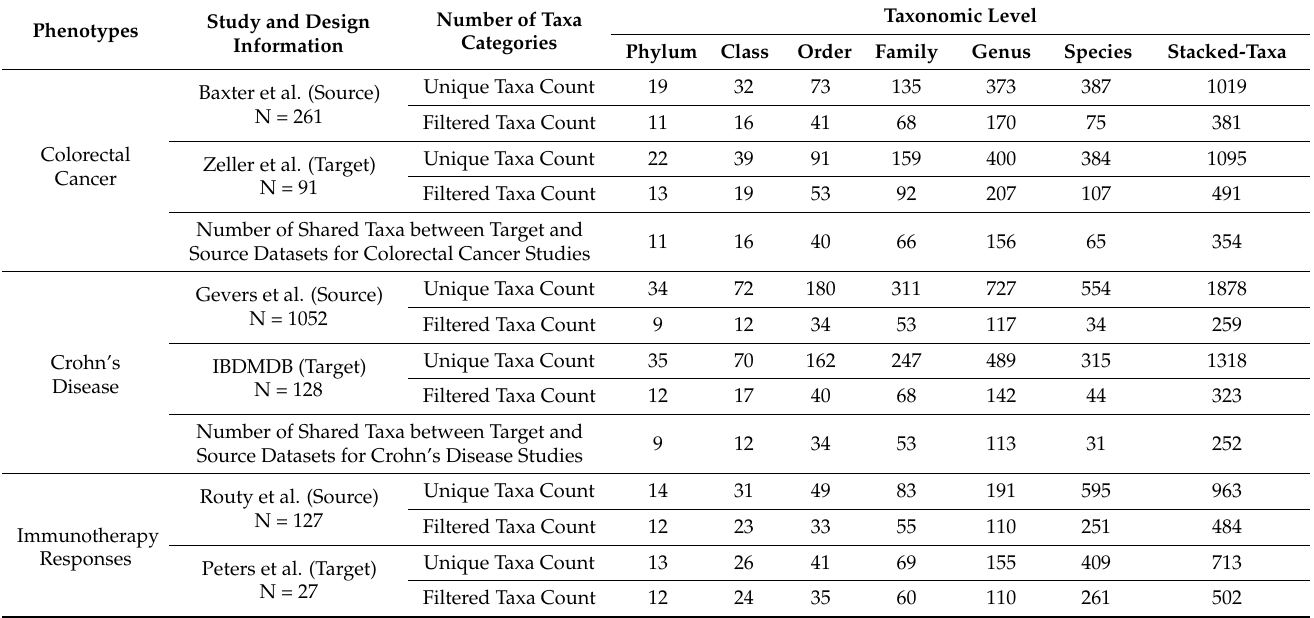
Table 1. Study taxonomic